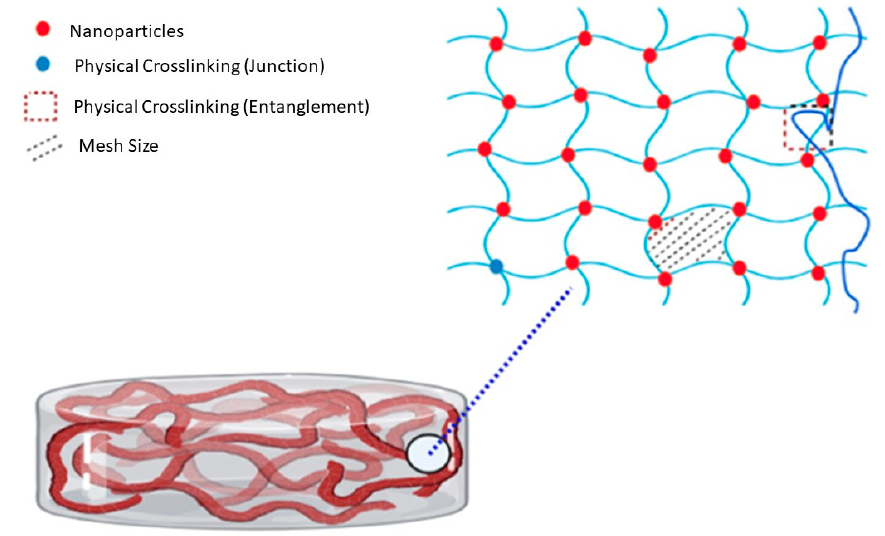
Figure 1. Schematic diagram of nanocomposite polymeric membranes.